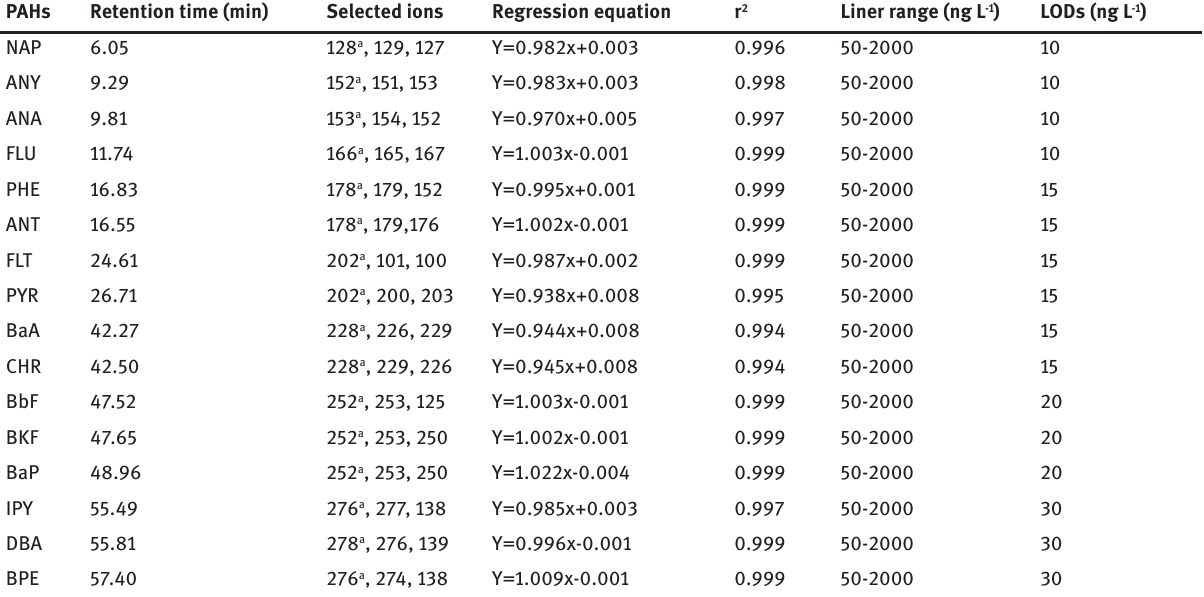
Table 1: Analytical performances of the developed method. PAHs Retention time (min) Selected